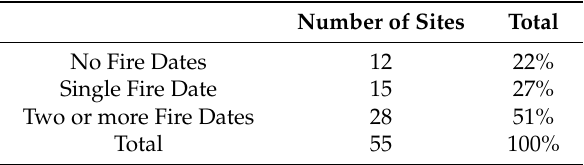
Table 2. Summary of fire history sites investigated for this